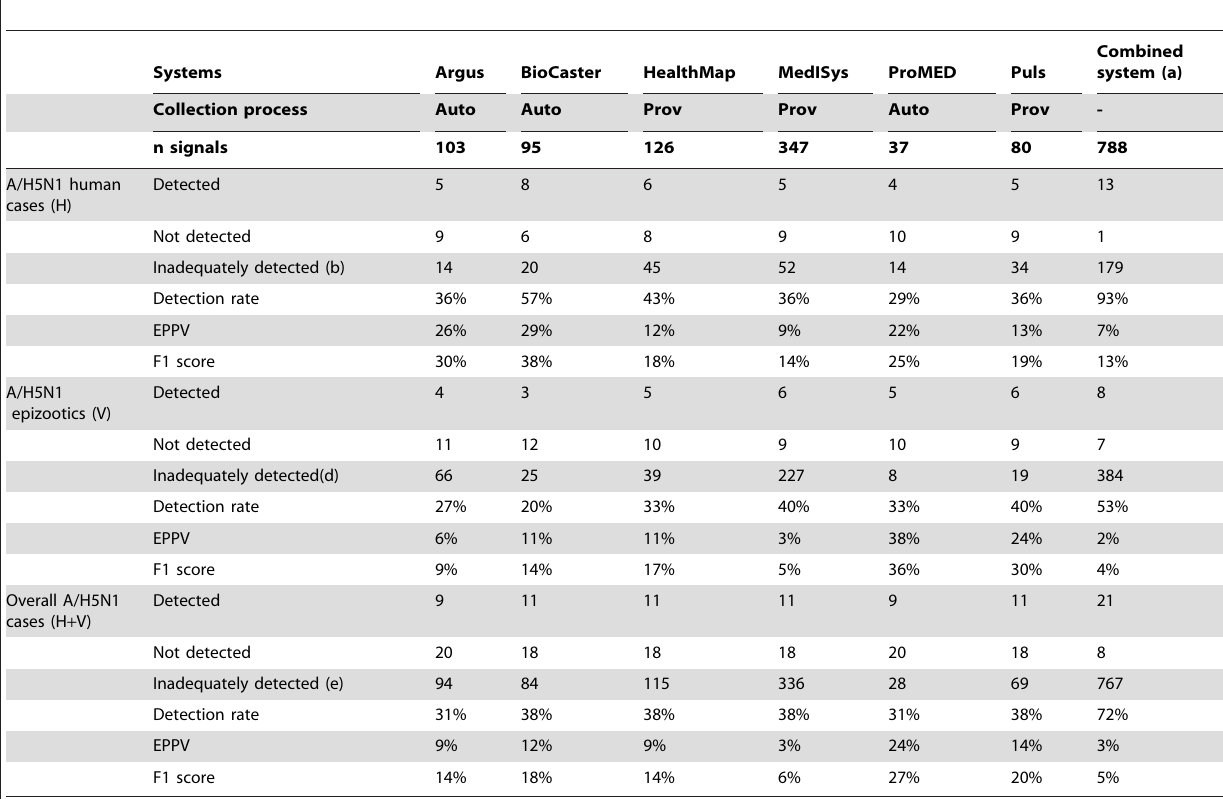
Table 3. Detection rate, positive predictive value and F1 score for A/H5N1 human cases and epizootic detected by systems from 1st to 31 st March